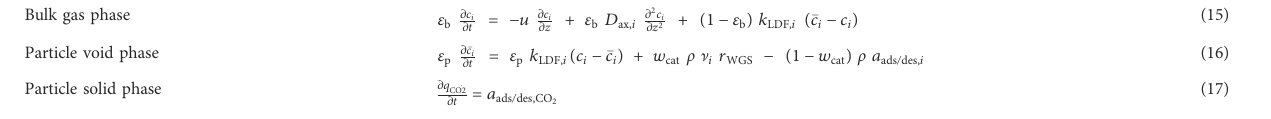
TABLE 1 Reactor model equations for bulk and particle phase. Bulk gas